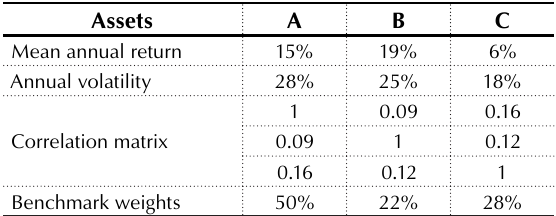
Table 1. Stylized input